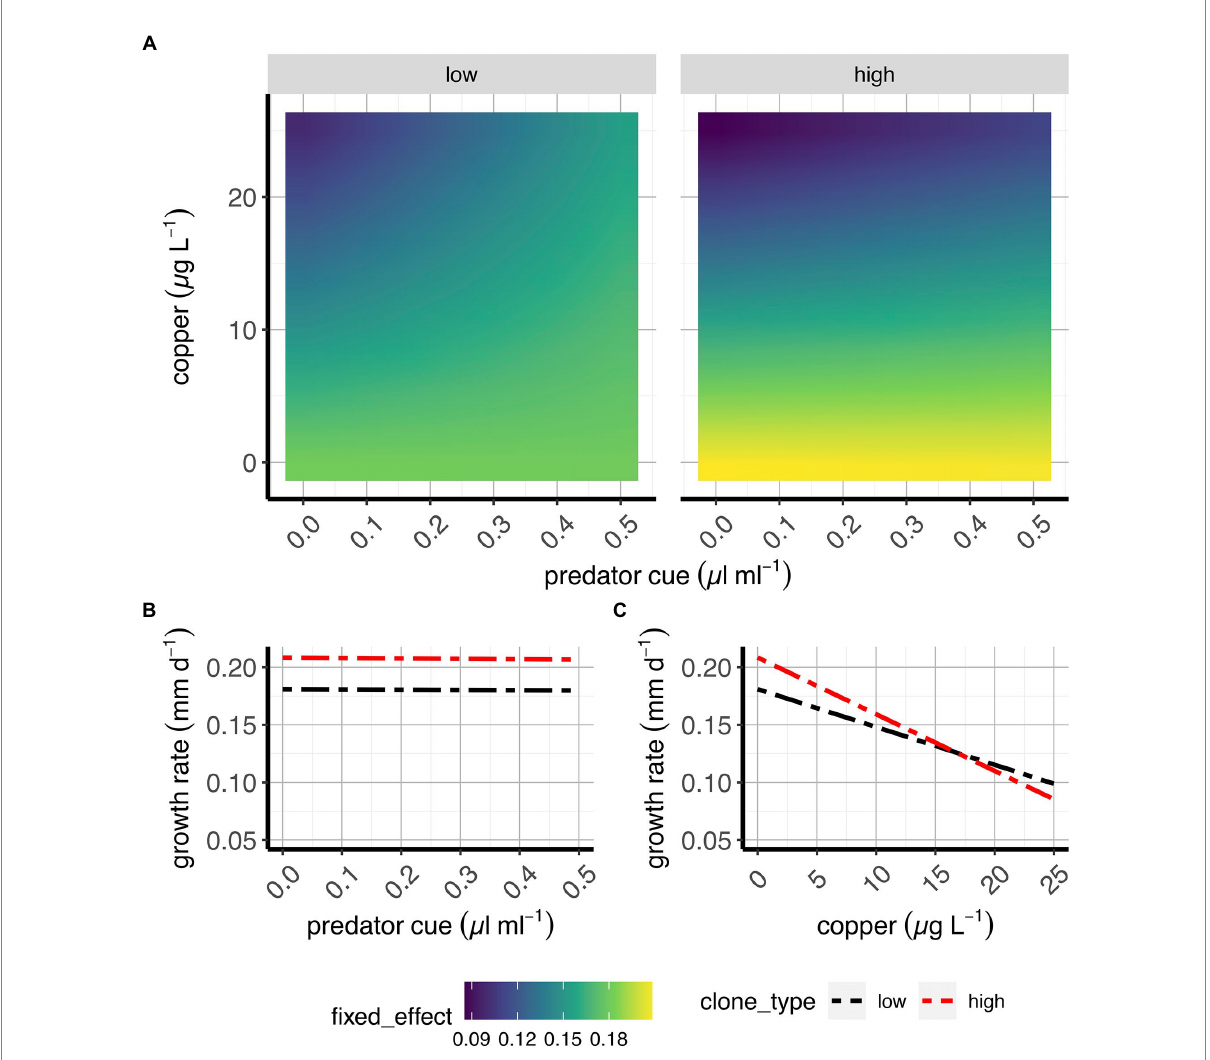
FIGURE 4 Somatic growth rate in two classes of D. pulex genotypes. (A) Contour plots of the average fixed effects portion of the model showing the overall response (here: somatic growth rate) to copper and predation in “high inducers” and “low inducers.” (B,C) Average effects of risk of predation (B) and sub-lethal copper concentrations (C) on somatic growth rate when copper and risk of predation, respectively, are absent (e.g., references for each treatment). X-axes present predator cue (A,B) or copper concentrations (C) , and y-axis denote copper concentrations (A) or somatic growth rate estimates (B,C)